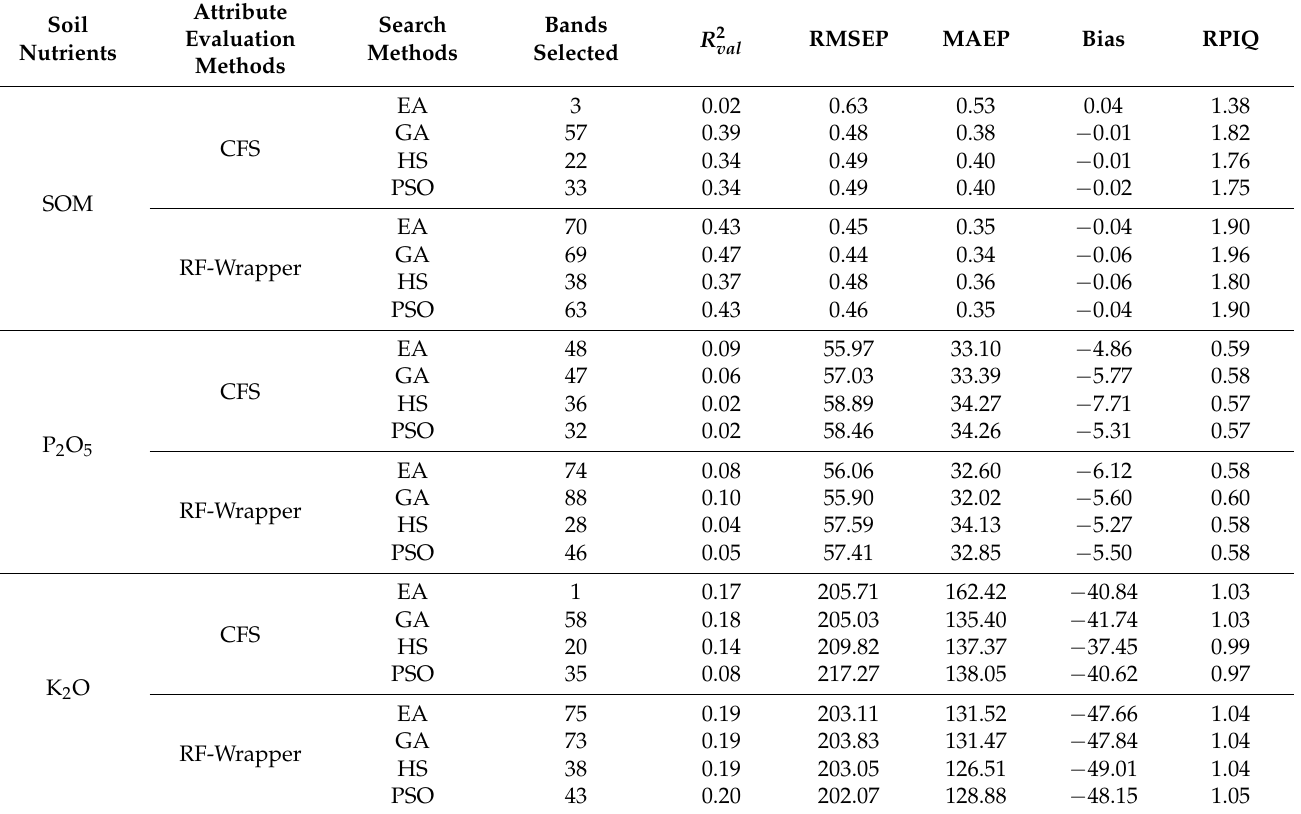
Table 5. Performance comparison of feature subset selection methods based on soil nutrients prediction